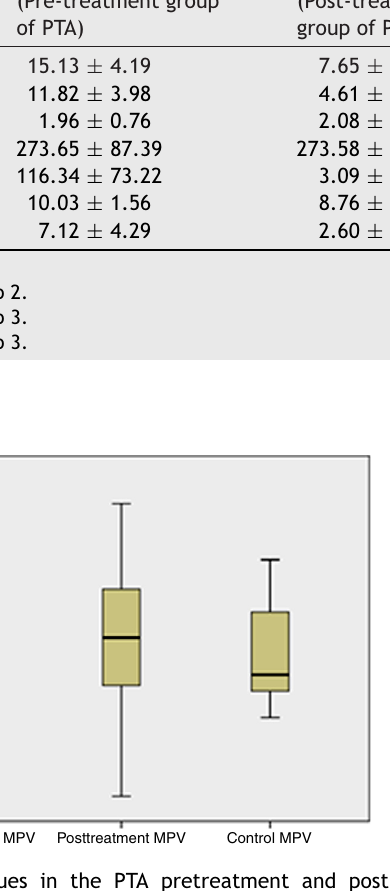
Figure 1 MPV values in the PTA pretreatment and post- treatment groups and the control group.